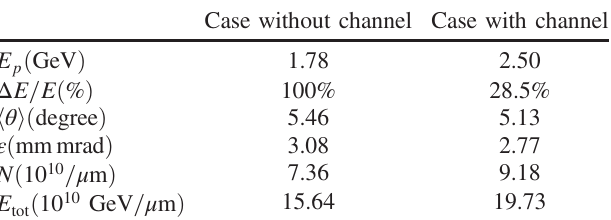
TABLE I. The final peak energy ( E p ), energy spread ( Δ E=E ), average divergence angle ( h θ i ), and transverse emittance ( ε ) of all protons in both cases at t ¼ 500 fs. The number ( N ) and total energies ( E ) of high-energy protons with energy larger than tot 1.5 GeV are also calculated.